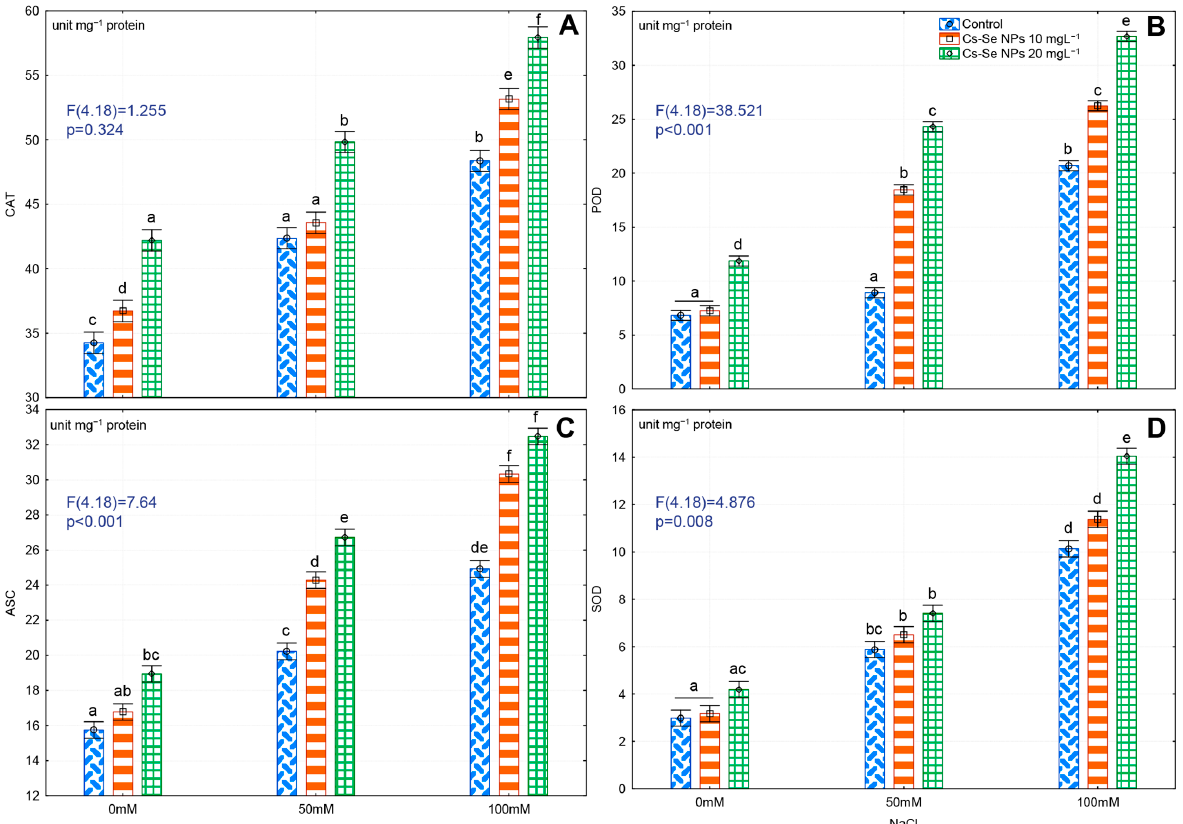
Figure 4. Effect of increasing concentration of Cs–Se NPs on CAT ( A ), POD ( B ), APX ( C ), and SOD ( D ) enzyme activity in bitter melon ( Momordica charantia ) leaves under salinity stress. The SDs denoted by lower-case letters in the same treatment indicate significant differences at p <0.05 by Tukey’s post hoc test.